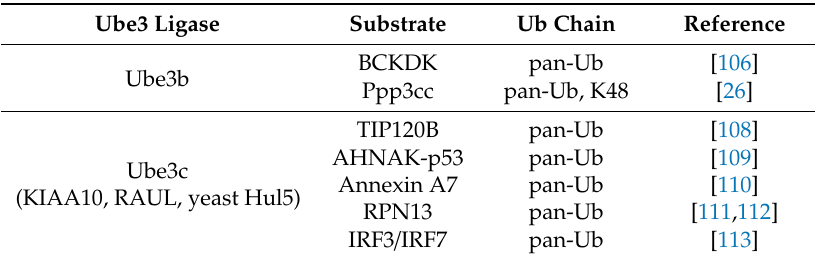
Table 2. Ubiquitination substrates of Ube3b and